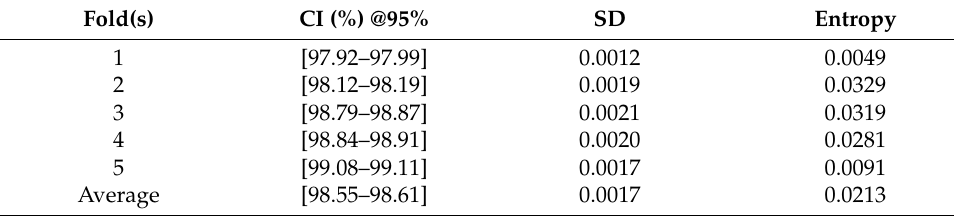
Table 5. Model uncertainty analysis outcome for dataset_1.